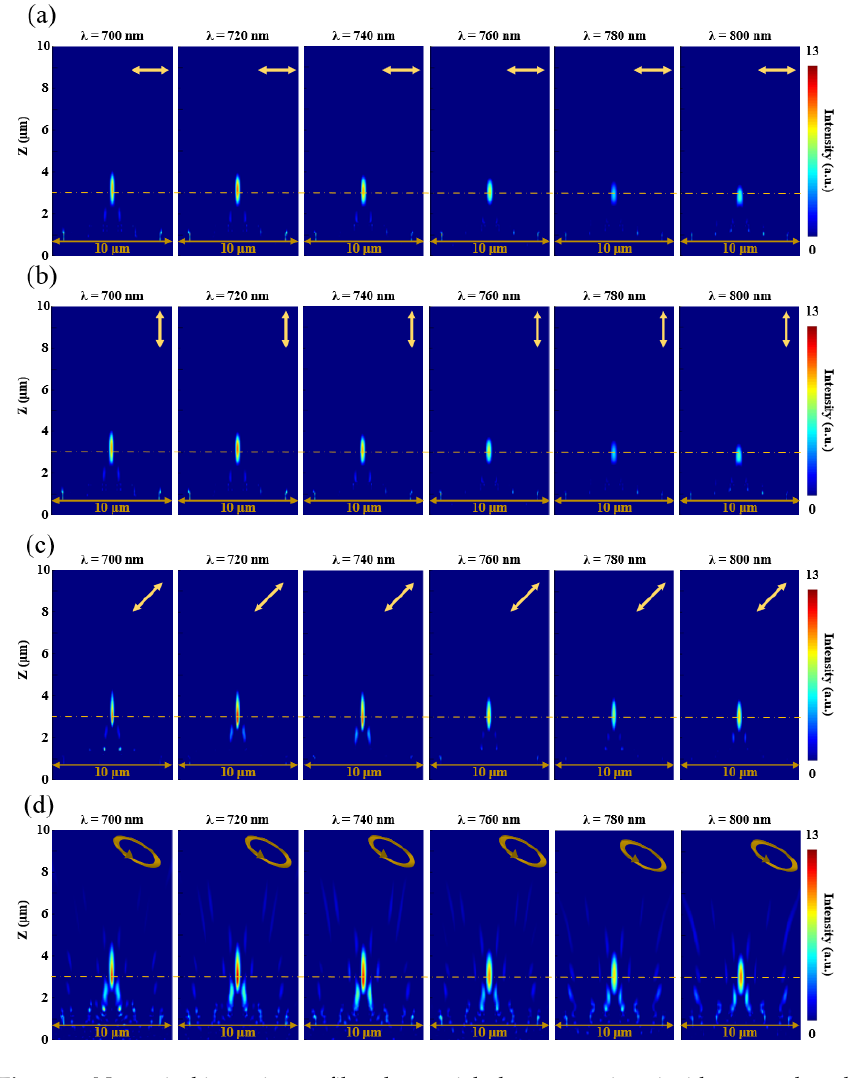
Figure 7. Numerical intensity profiles along axial planes at various incident wavelengths for ( a ) XLP, ( b ) YLP, ( c ) 45 ◦ linearly polarized (45 ◦ -LP) and ( d ) elliptically polarized (EP) incident